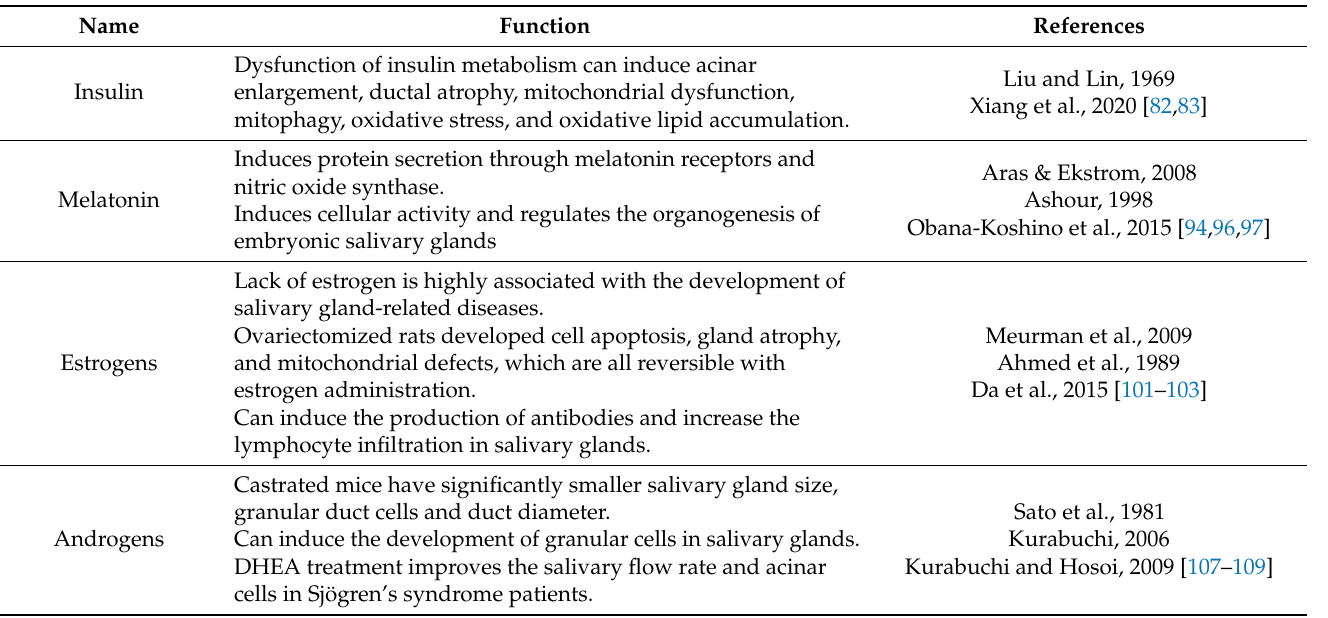
Table 3. Several key endocrine-related metabolites in salivary